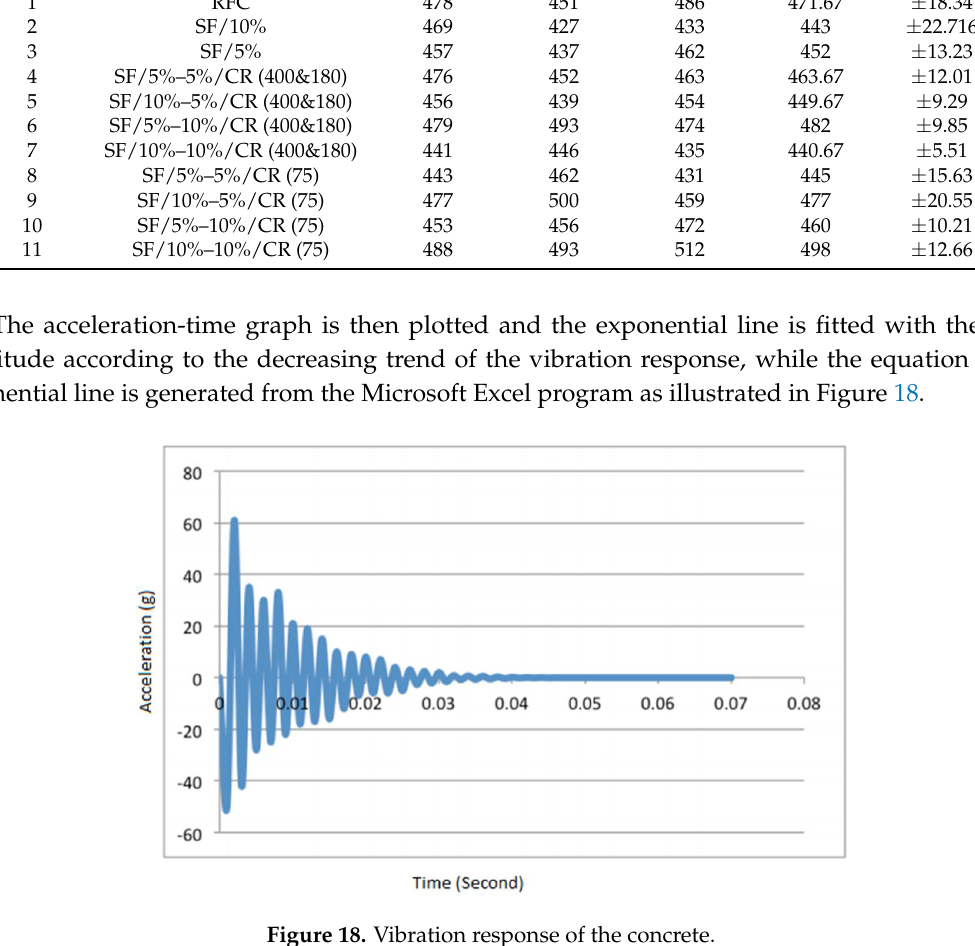
Figure 18. Vibration response of the concrete.